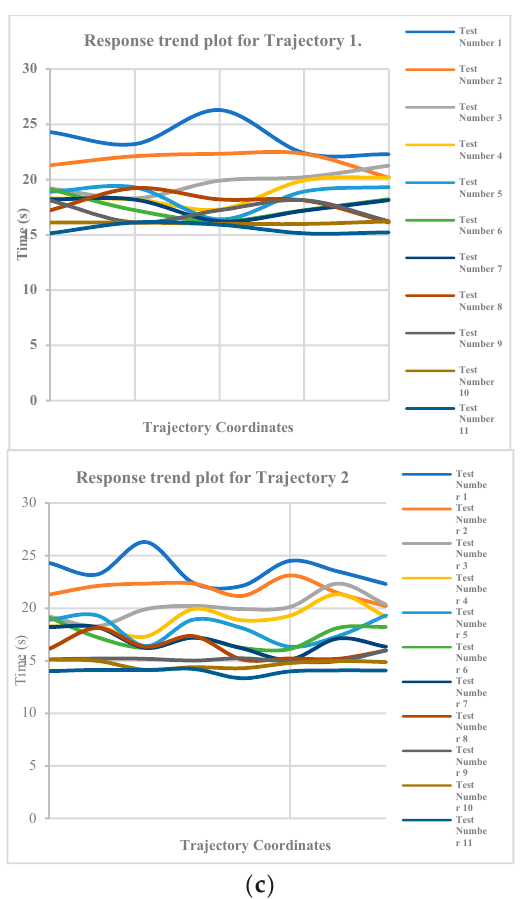
Figure 19. ( a ) Point-to-point trajectories (Trajectory 1 and Trajectory 2), ( b ) The time and the number of penalties (Trajectory 1 and Trajectory 2) and ( c ) Plot of trend response for each trajectory (Trajectory 1 and Trajectory 2).